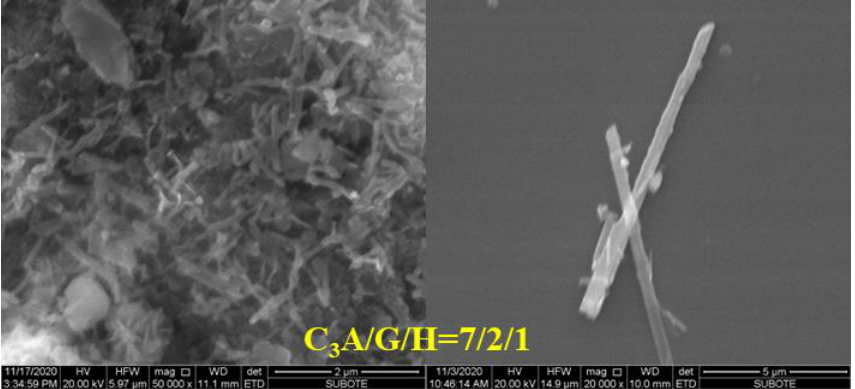
Figure 8. Morphology of precipitated ettringite and gypsum in the C 3 A-gypsum systems with hem- ihydrate.